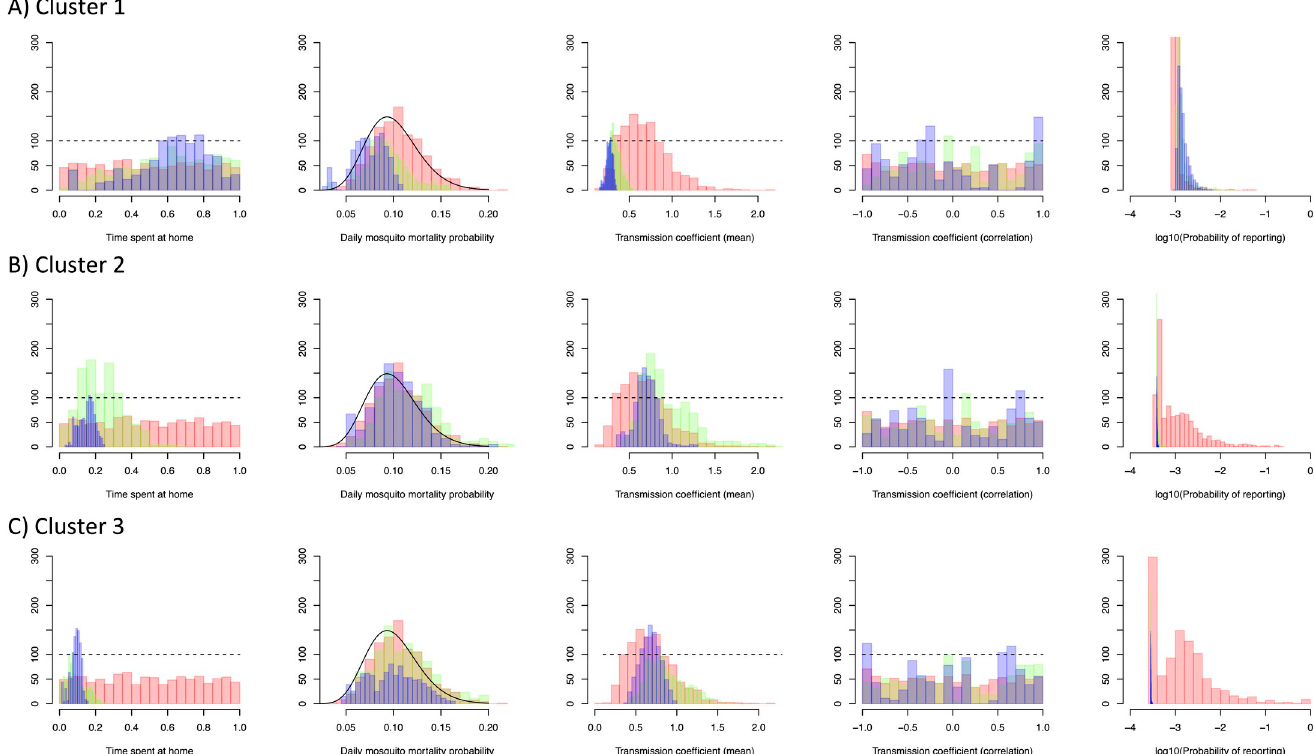
Fig 4. Histograms of the distribution of each model parameter using the best fitting human movement model (exponential for cluster 1, gravity for clusters 2 and 3) over successive sequential Monte Carlo rounds (Red = round 1, Green = round 2, Blue = Round 3). Probability of reporting is on a logarithmic scale (base 10).